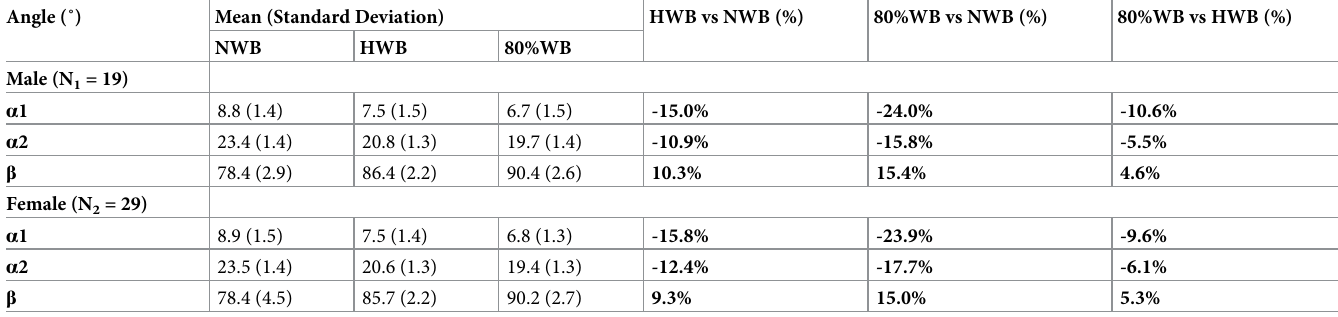
Table 3. ANOVA analysis and change percentage of angle for NWB, HWB, and 80%WB groups. Angle